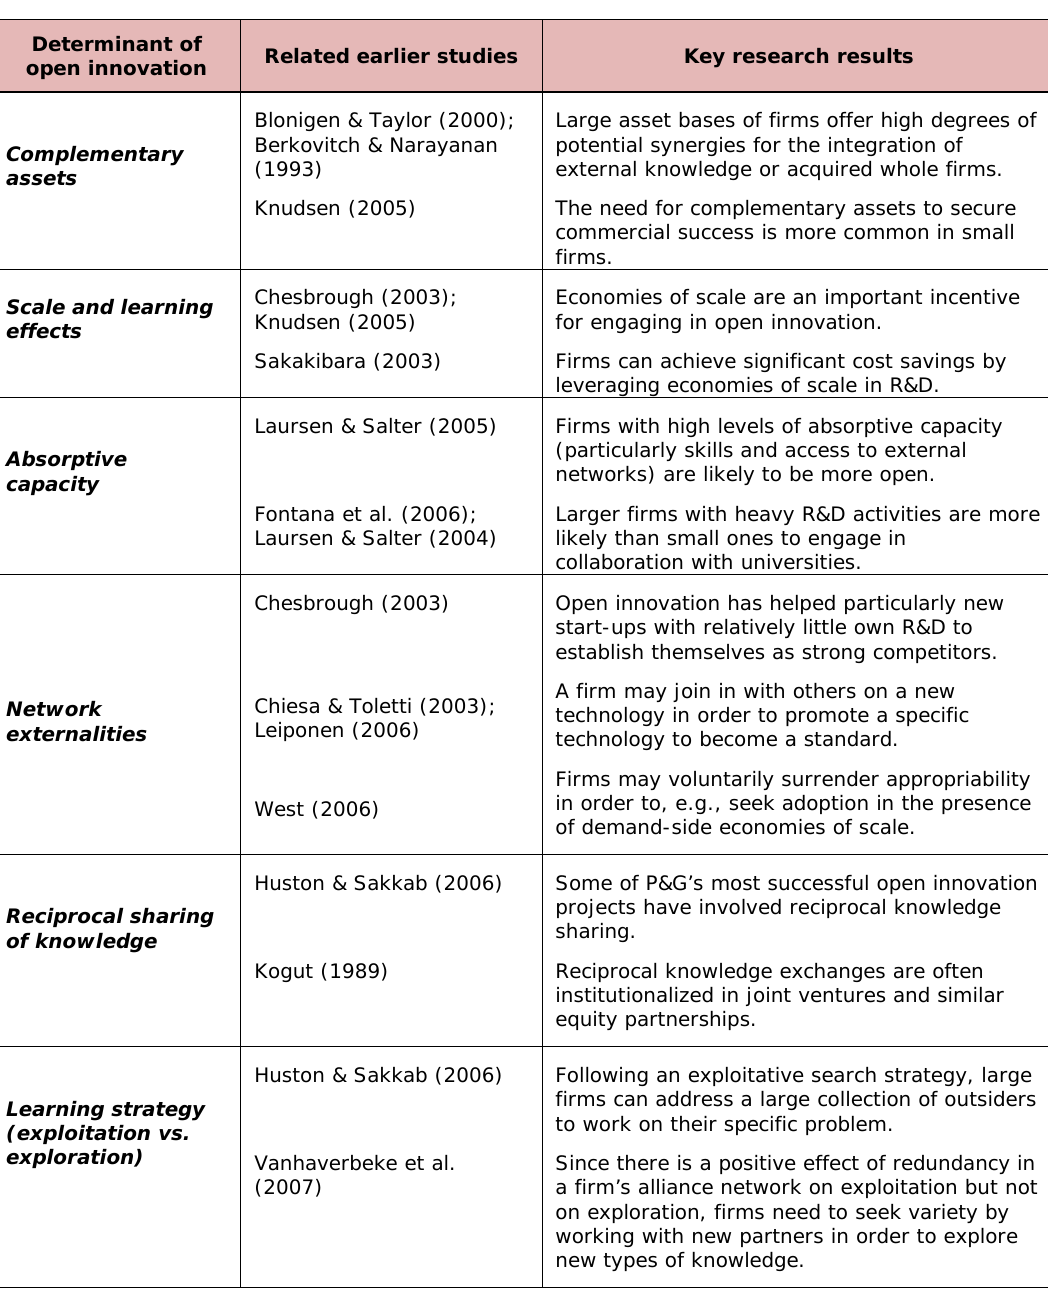
Table 1. Determinants of open innovation and related earlier research